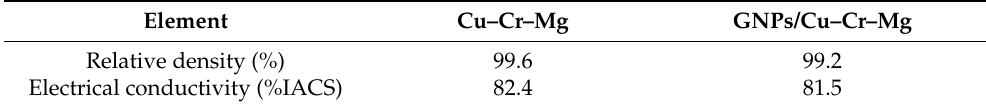
Table 2. Relative density and electrical conductivity of the